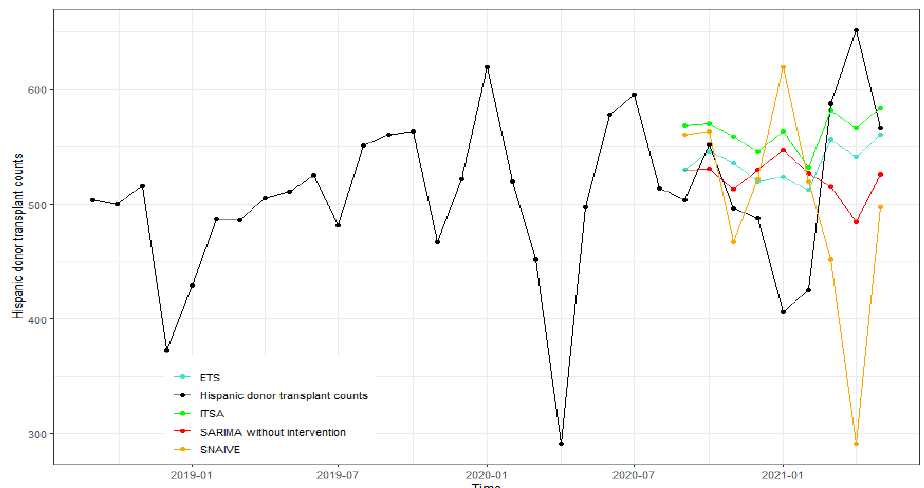
Figure 14. Forecasts of the Hispanic donor transplants from September 2020 to May 2021 using ITSA, SARIMA without intervention, ETS, and SNAIVE. Table 7. Forecast accuracy measures by ethnicity at various forecast